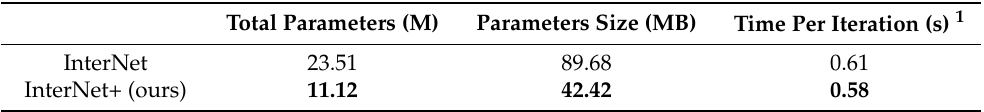
Table 3. The comparison of the parameters of our method and the original InterNet and the speed of the experiment.